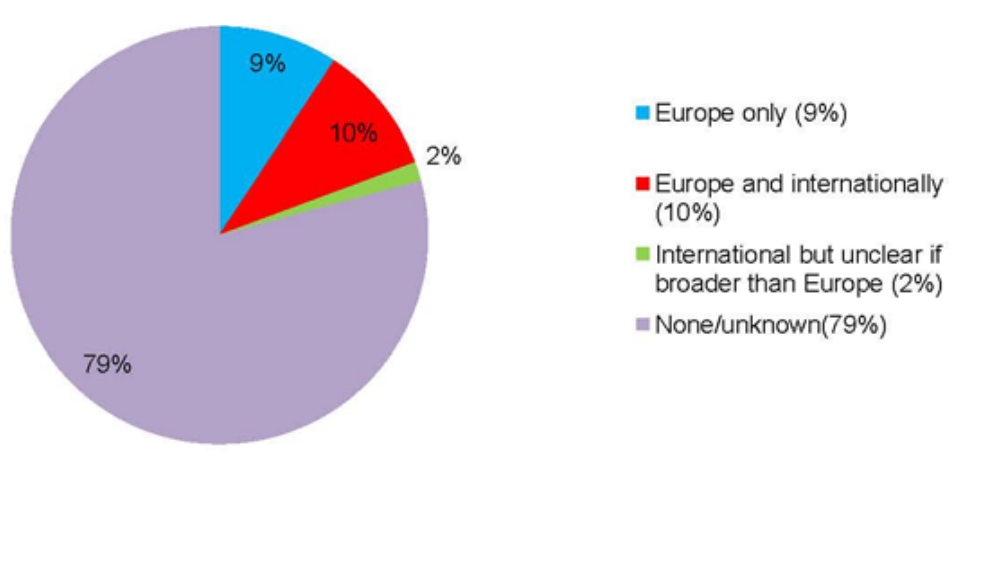
Figure 5: Type of organisation responsible for setting up the activity and ultimately controlling its continuance (shown as